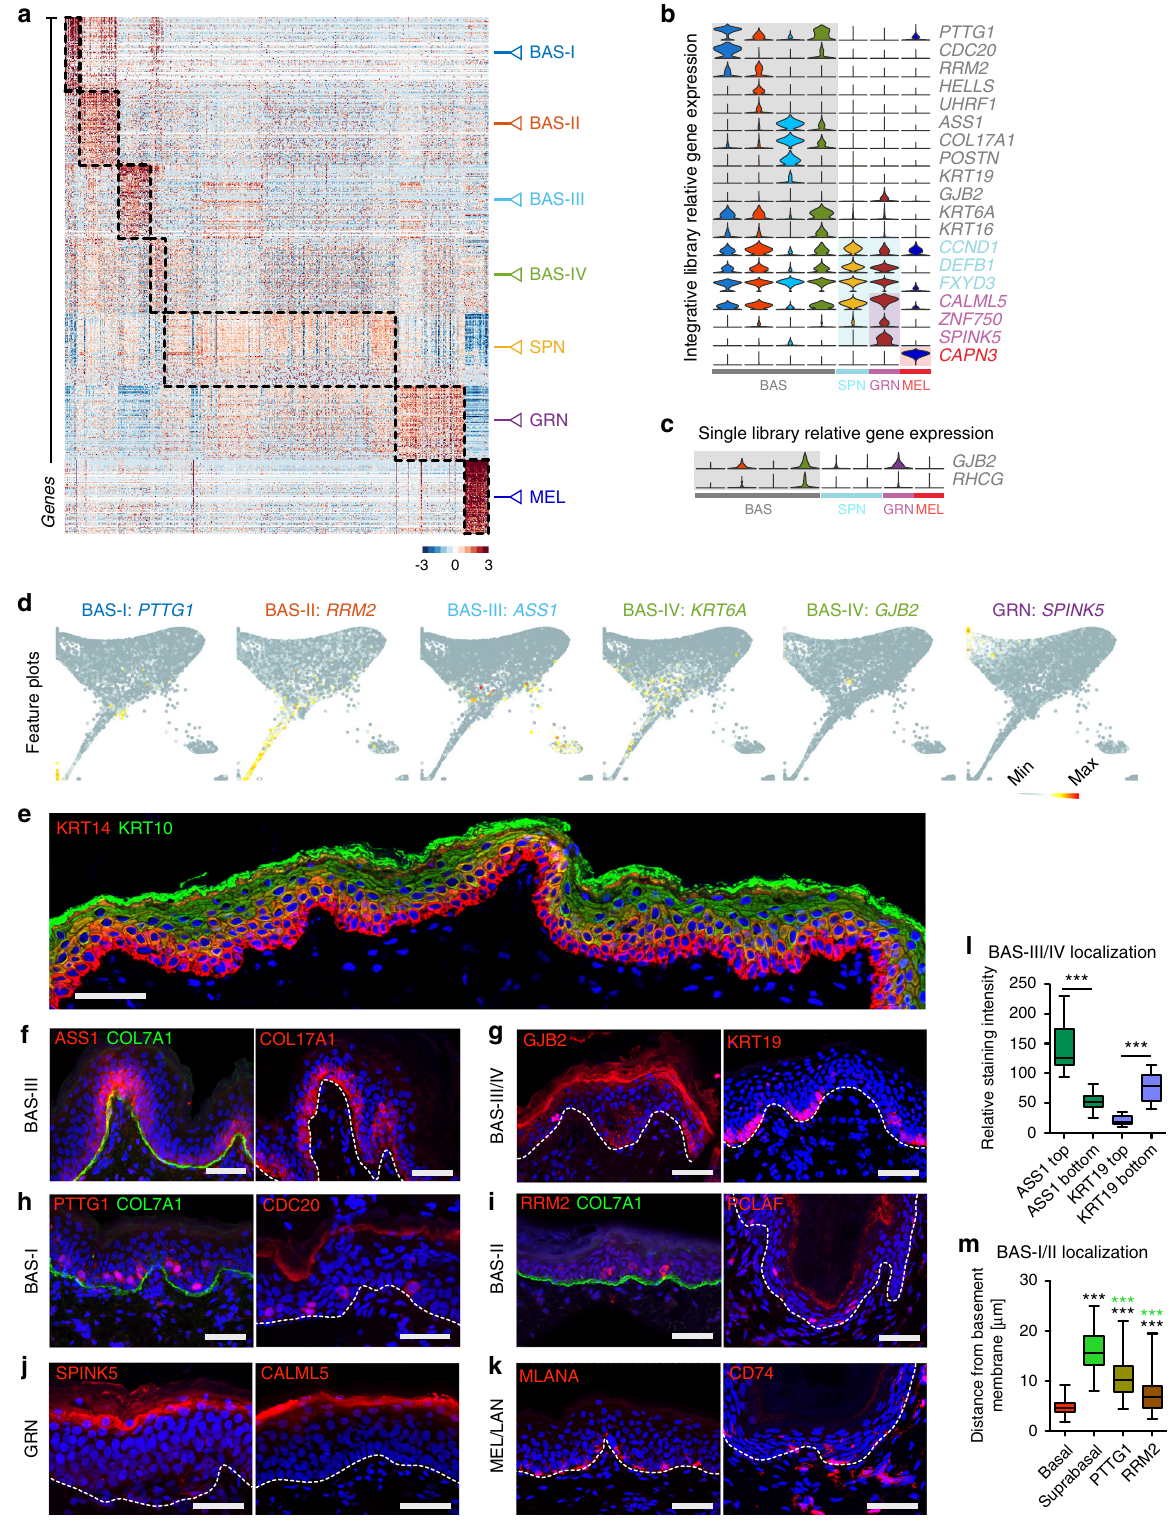
algorithm featured in SoptSC. Signaling relationships in SoptSC are calculated based on differential gene expression and co- variance of speci fi c signaling pathway components. Signaling probabilities between cells are then de fi ned and quanti fi ed based on the weighted expression of signaling pathway components between sender-receiver cell pairs inferred via expression